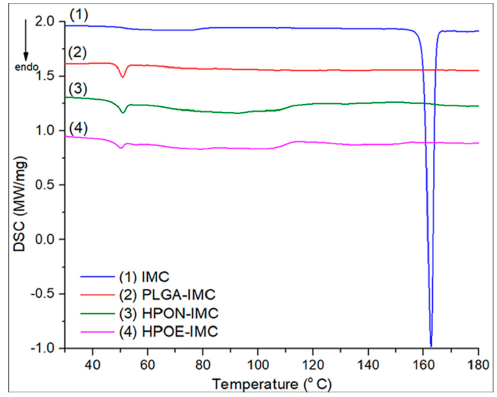
Figure 4. DSC thermograms of analyzed samples.